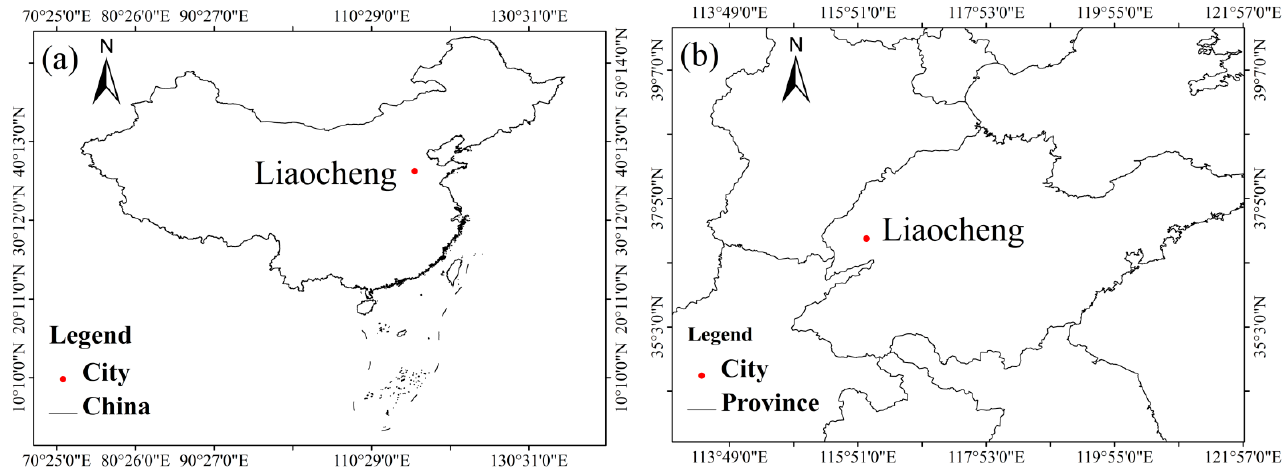
Figure 1. Location of Liaocheng in Shandong Province, China. ( a ) The location of Liaocheng in China, ( b ) The location of Liaocheng in Shandong Province.